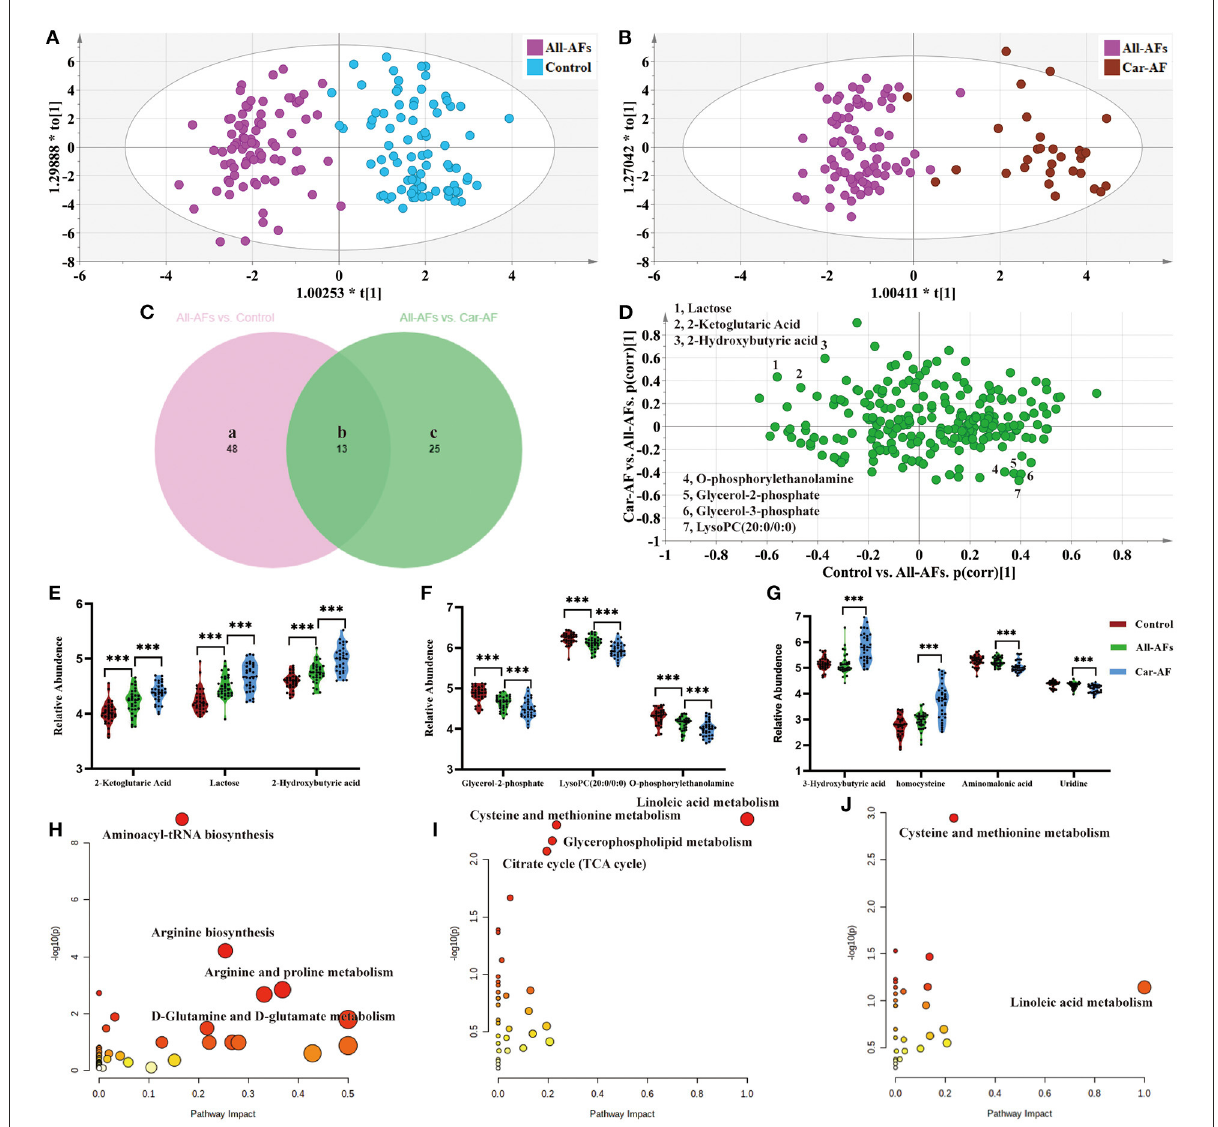
FIGURE5 Differential metabolites and pathways involved in different groups. (A) OPLS-DA modeling delineates different metabolic phenotypes of Control and All-AFs cardiac cases. R2X(cum) = 0.343, R2Y(cum) = 0.861, Q2X(cum) = 0.712. Permutation tests with the intercepts of R2 < 0.454, Q2 < − 0.542. (B) OPLS-DA model differentiating Car-AF patients from the All-AFs cases. R2X(cum) = 0.302, R2Y(cum) = 0.851, Q2X(cum) = 0.74. Permutation tests with the intercepts of R2 < 0.445, Q2 < − 0.515. (C) Venn diagram shows discriminant metabolites can be classified into regions a, b, and c. (D–G) SUS-plots and violin diagram delineate potential markers of Control, Car-AF, and All-AFs cardiac cases. SUS-plot highlights the potential markers of the All-AFs, Car-AF, and Control cases. "* * *" means p?0.01. (H) Pathway analysis of differential metabolites in Venn a and b regions. (I) Pathway analysis of differential metabolites in Venn b and c. (J) Pathway analysis of differential metabolites in Venn c. *** p <